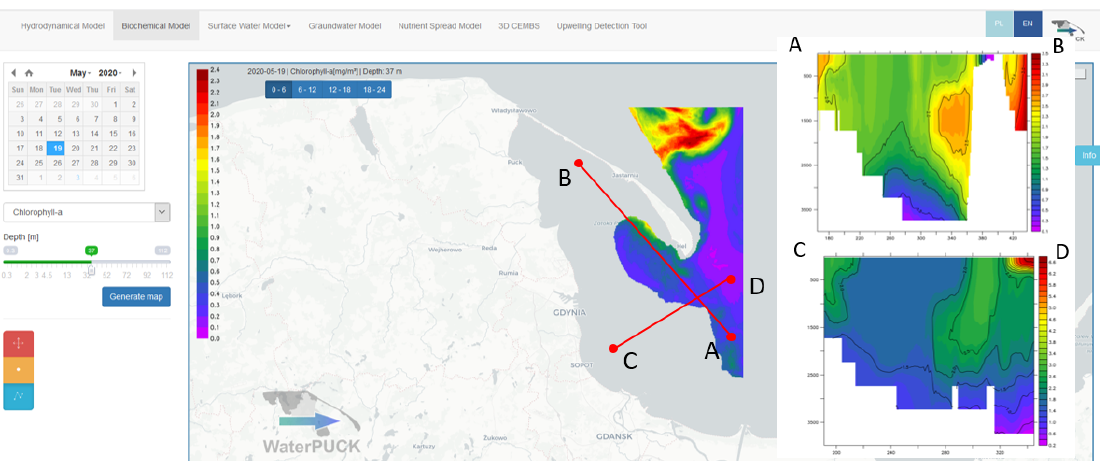
Figure 16. Screenshot of spatial distribution of chlorophyll-a concentration and sample cross sections (AB—end points of the cross-section along the Hel Peninsula, CD—end points of the cross-section perpendicular to the Hel